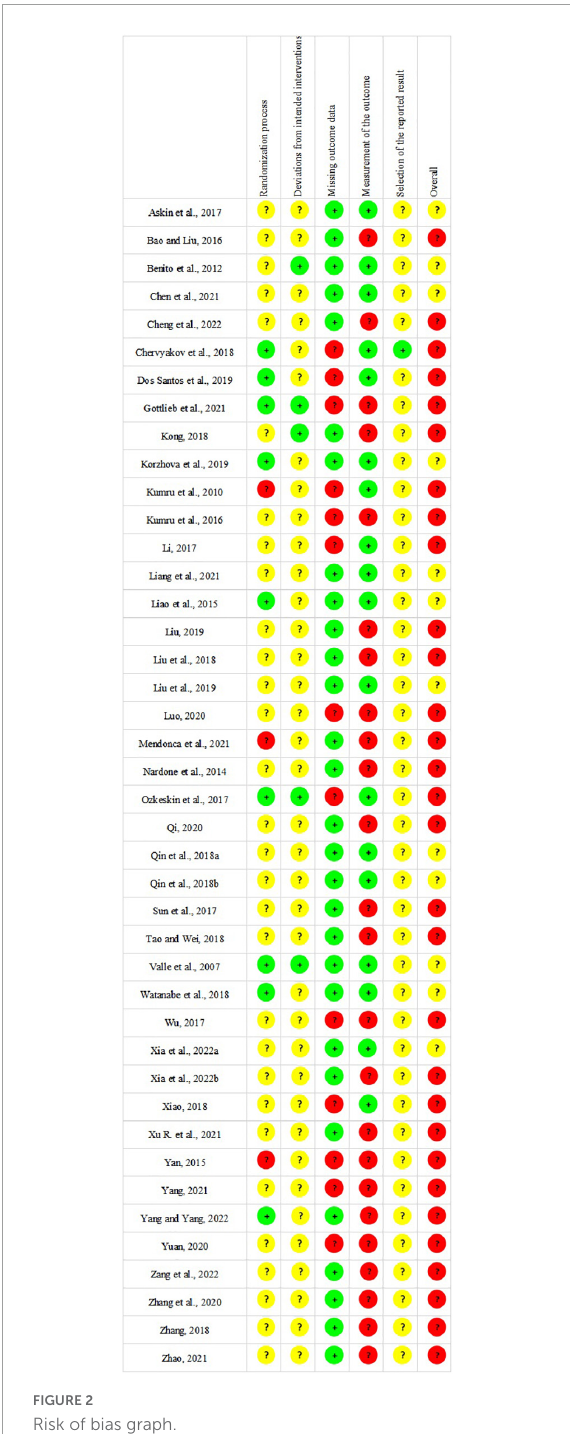
FIGURE2 Risk of bias graph.